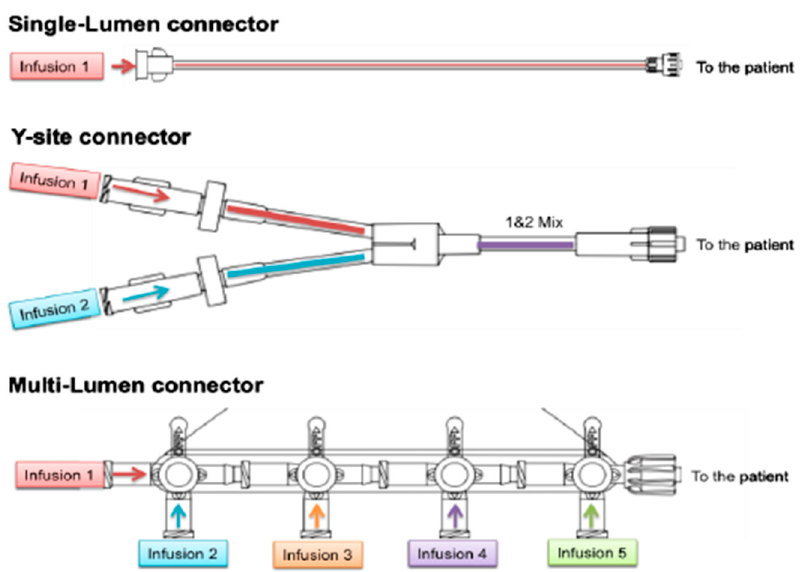
Figure 3. Di ff erent types of connectors (adapted from IV Sets and Access Devices Product Catalog—B. Figure 3. Different types of connectors (adapted from IV Sets and Access Devices Product Braun Medical Inc., e ff ective August Catalog—B. Braun Medical Inc., effective August 2017).